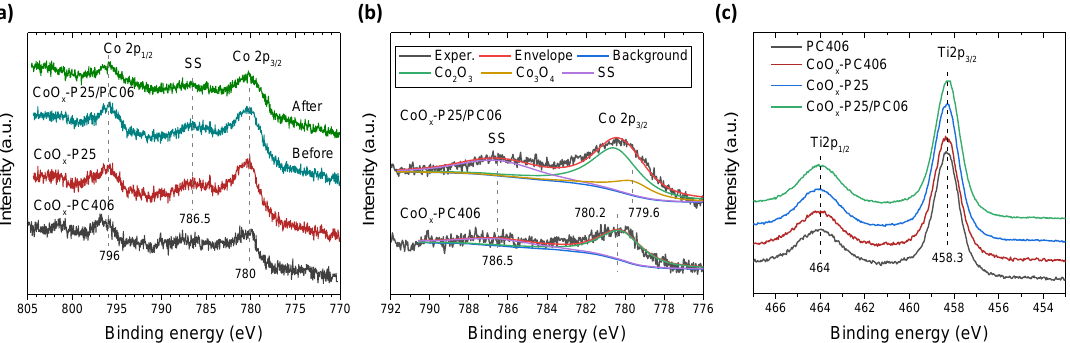
Figure 4. ( a ) Co 2p X-ray photoelectron spectra (XPS) of CoO x -TiO 2 films. The XPS after the photocatalytic experiment is included for CoO x -P25 / PC406. ( b ) Deconvolution of the Co 2p 3 / 2 spectra for CoO x -PC406 and CoO x -P25 / PC406. ( c ) Comparative Ti 2p spectra for pristine and surface-modified CoO x -TiO 2 films.